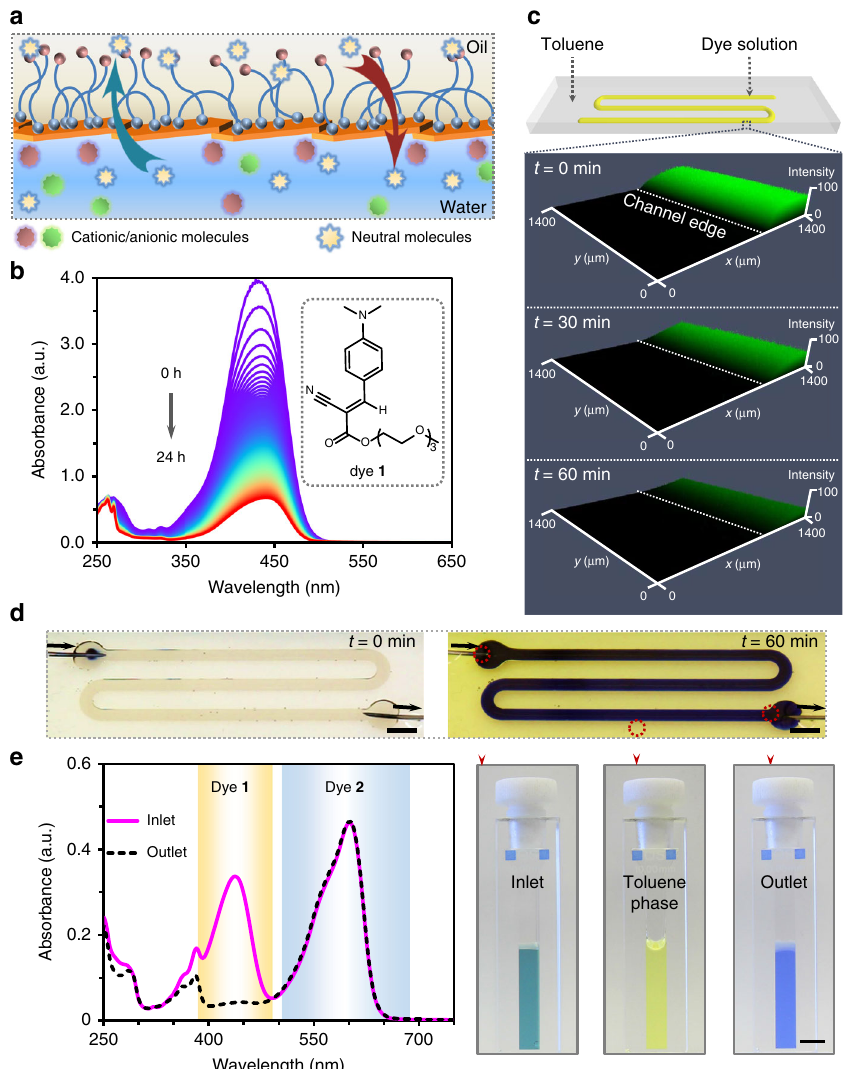
Fig. 2 Semi-permeability of 2D NPS interfacial fi lms. a Schematic showing selective mass transfer across the water – oil interface through the NPS fi lm. b Stacked UV – Vis spectra of a neutral dye ( 1 ) at 5-min time-intervals, monitoring dye transfer from water to toluene across the NPS membrane fi lm in a masked cuvette. The inset shows the chemical structure of dye 1 engaged in mass transfer. c LSCM images of the fl uidic channel after infusing dye 1 solution in the preformed liquid channel covered by toluene. d A fl uidic device depicting the fl ow of a mixed solution of dye 1 and resazurin sodium ( 2 ) for chemical separation. [ 1 ] = 1.4 mg mL − 1 , [ 2 ] = 1 mg mL − 1 . Photographs of the diluted inlet, outlet, and overlay of toluene solutions collected in cuvettes show the dye separation after infusing the mixed solution at a fl ow rate of 0.2 mL h − 1 for 1 h. Scale bar, 5 mm. e UV – Vis spectra of the diluted inlet and outlet solutions used to quantify the ef fi ciency of dye 1 partitioning from the aqueous phase to the toluene phase. NPS nanoparticle − polymer surfactant, LSCM laser scanning confocal